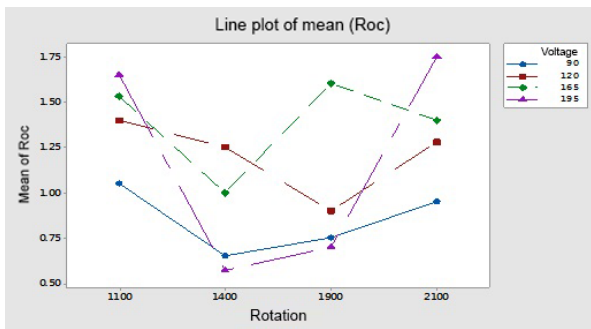
Figure 15. Rotation and voltage relation of OC 1 for the cryogenic tool.